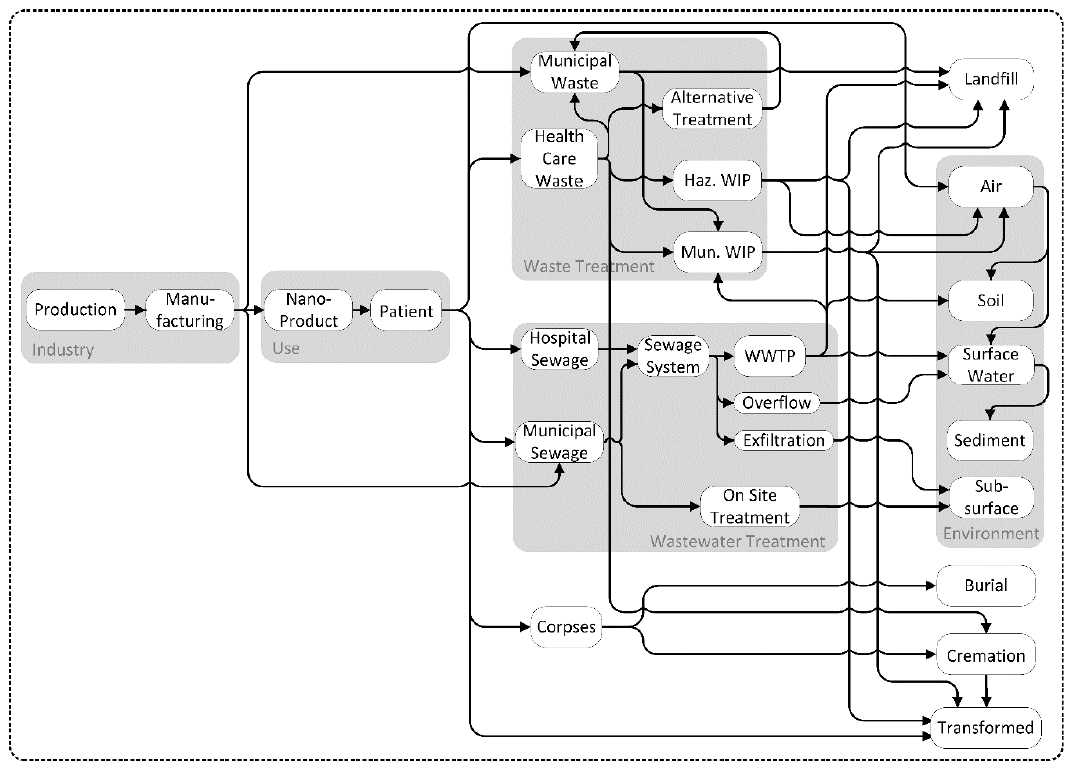
Figure 2. Material flow diagram for NBM from production to the intended use in patients, the wastewater and waste treatment specific to the use in hospitals and finally to the environment.